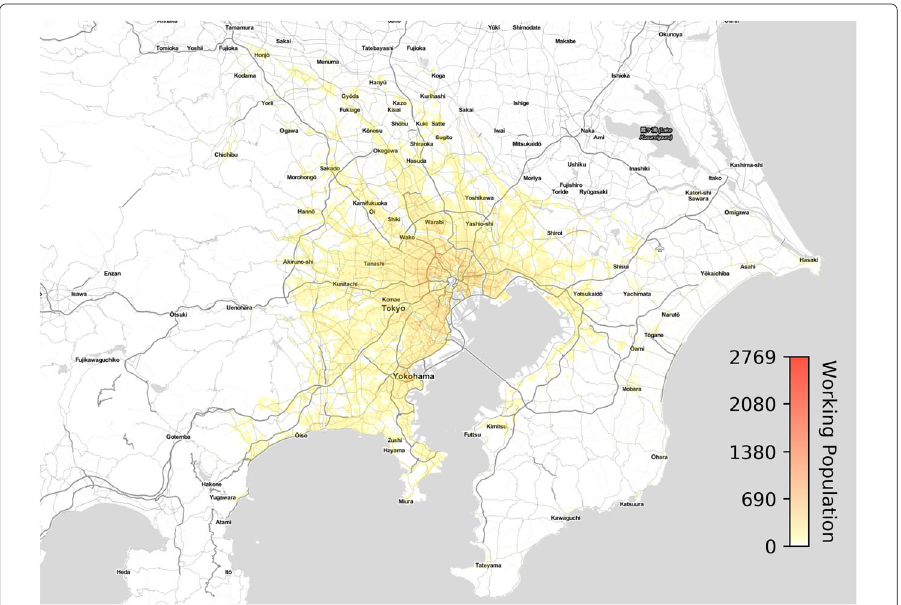
Fig. 1 A map of the Tokyo area used in the analysis with the hex grid overlay showing the working age population data. Map tiles by Stamen Design (2019), map data by OpenStreetMap (2019)